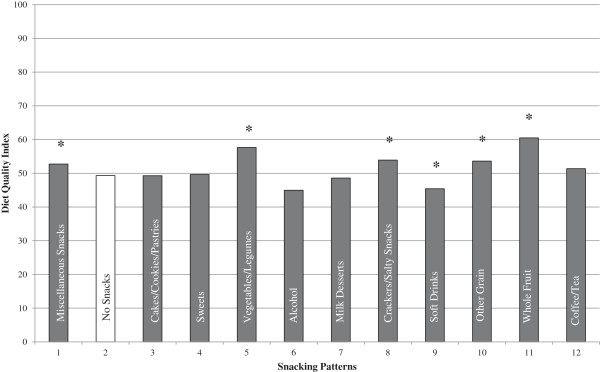
Snacking patterns and overall diet quality (HEI-2005) for adults ≥ 19 years of age. Covariates: Age, gender, race/ethnicity, poverty income ratio grouped into three categories as (<1.25, 1.25-3.49, and >3.49), current smoking status yes/no) (adults only), physical activity level (sedentary, moderate and vigorous), alcohol intake (g/d). Note that energy was not used as a covariate since the HEI score itself is controlled for energy. *Significantly different from no snacking (pattern 2); Bonferroni correction p ≤ 0.0042.